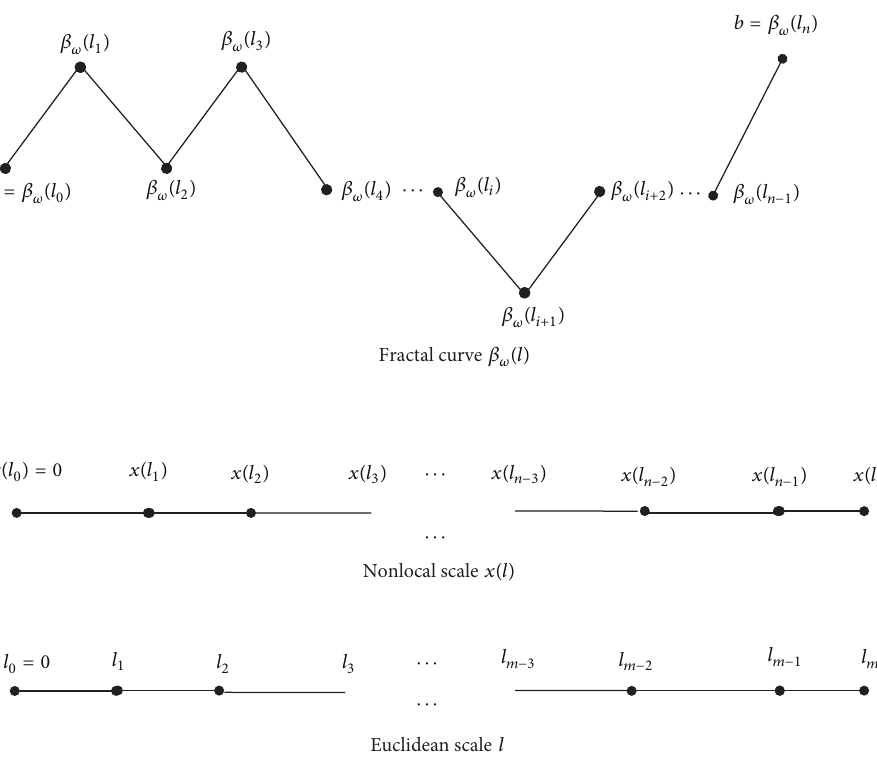
Figure 3: The fractal curve 𝛽 𝜔 (𝑙) consists of the union ⋃ 𝑛 𝑖=1 [𝛽 𝜔 (𝑙 𝑖−1 ), 𝛽 𝜔 (𝑙 𝑖 )] , where 𝑛 = 𝑛(𝑚) . The dimension of fractal curve 𝛽 𝜔 (𝑙) equals ( ln 𝑛(𝑚)/ ln 𝑚) . Since 𝛽 (𝑙) is a fractal curve, the distance between points 𝛽 𝜔 = lim 𝑚→∞ 𝜔 Euclidean scale (ruler) 𝑙 ; otherwise, we will have 𝑑[𝛽 𝜔 (𝑙 0 ),𝛽 𝜔 (𝑙 𝑛 )] = lim 𝑚→∞ 𝑛(𝑚)((𝑙 𝑚 − 𝑙 0 )/𝑚) = ∞ or = 0. However, the fractal curve 𝛽 𝜔 (𝑙) can be measured using the nonlocal scale (ruler) 𝑥(𝑙) ; for the way of measure see the formula